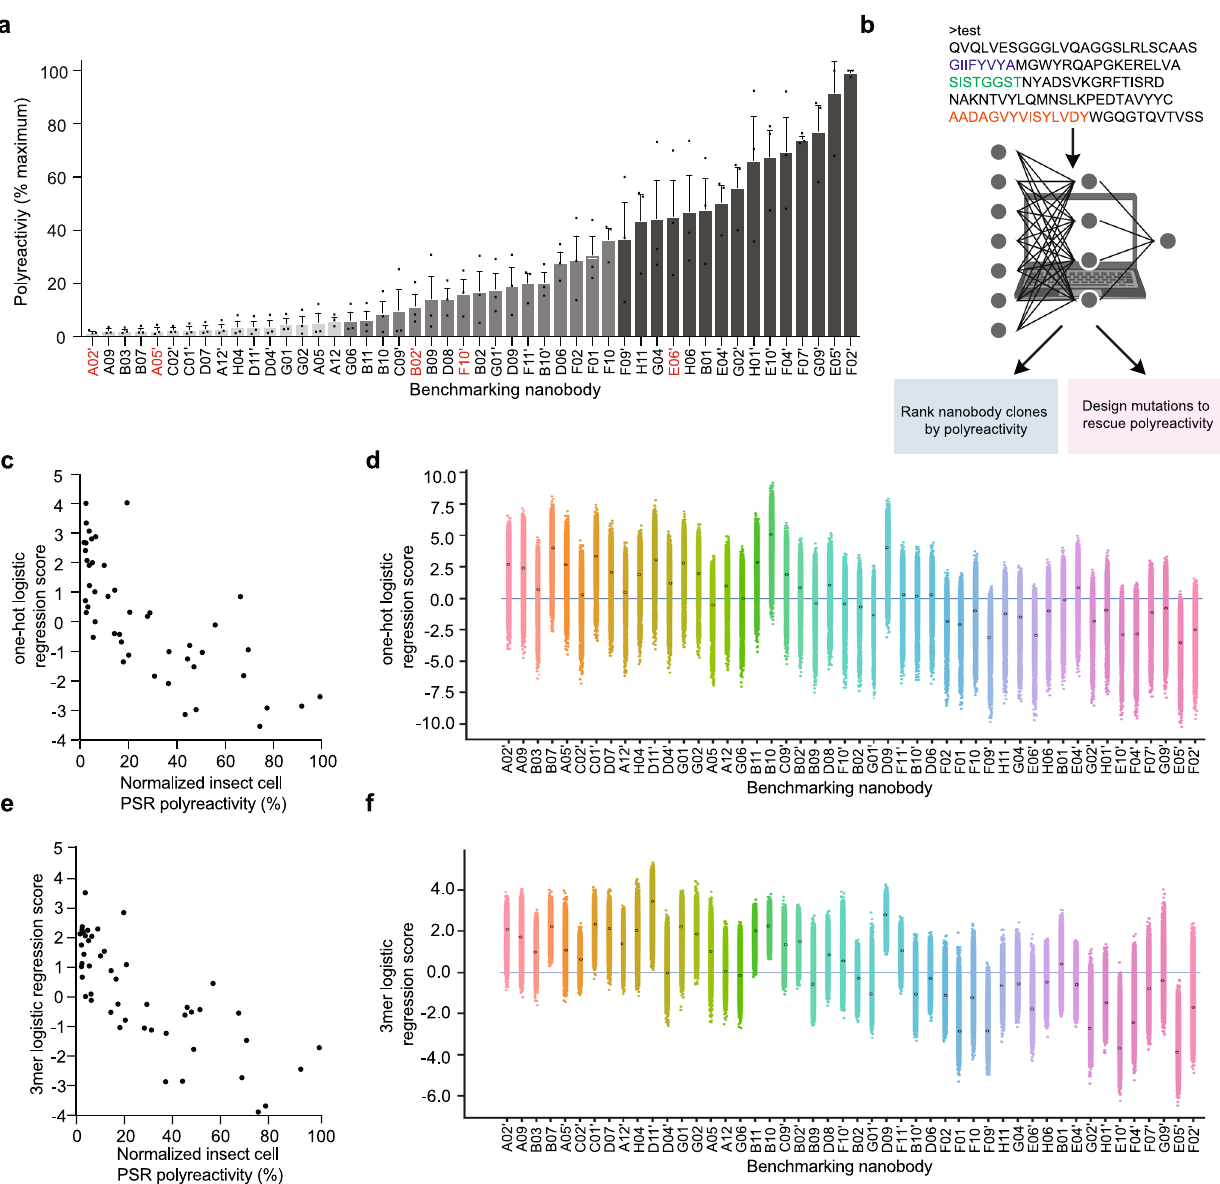
Fig. 4 | Validation of computational model for quantitative predictions of polyreactivity and generationofrescue mutations.a Generationofanindexset of polyreactivity mutants by Spodoptera frugiperda (Sf9) insect cell membrane protein polyspeci fi city reagent ( PSR) staining of yeast displaying 48 unique nano- bodies isolated from MACS enrichment as well as non-reactive and polyreactive FACS pools. Data are mean +/ − SEM of three independent biological experiments performed intechnical triplicate. b Newnanobodysequence(s) can be input into a webserver, which will output computational predictions of polyreactivity and biochemical properties of the sequence(s). It is also possible to input a nanobody sequence to retrieve top scoring rescue mutations predicted to decrease poly- reactivity. c , e The one-hot logistic regression model and k-mer logistic regression modeltrainedonthefullNGSdatasetfromFACSsortswithPSRbindingwereused